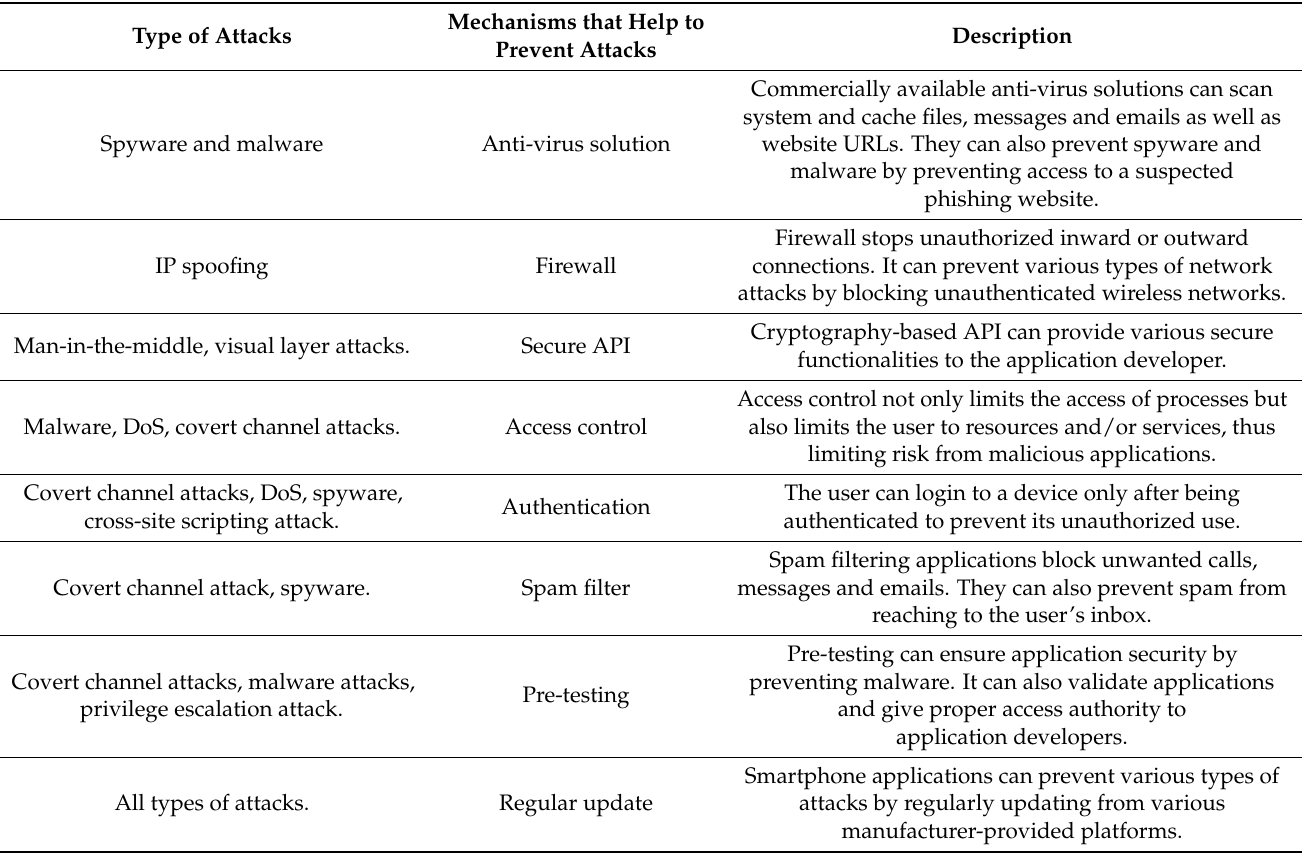
Table 3. Summary of security